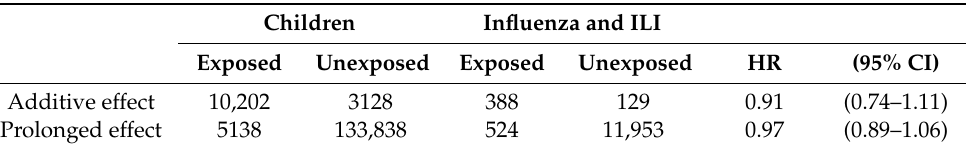
Table 1. Adjusted hazard ratio and 95% CI for evaluation of additive and prolonged effect of influenza vaccination among concomitant influenza seasons. Pedianet, 2009–2019. Children Influenza and